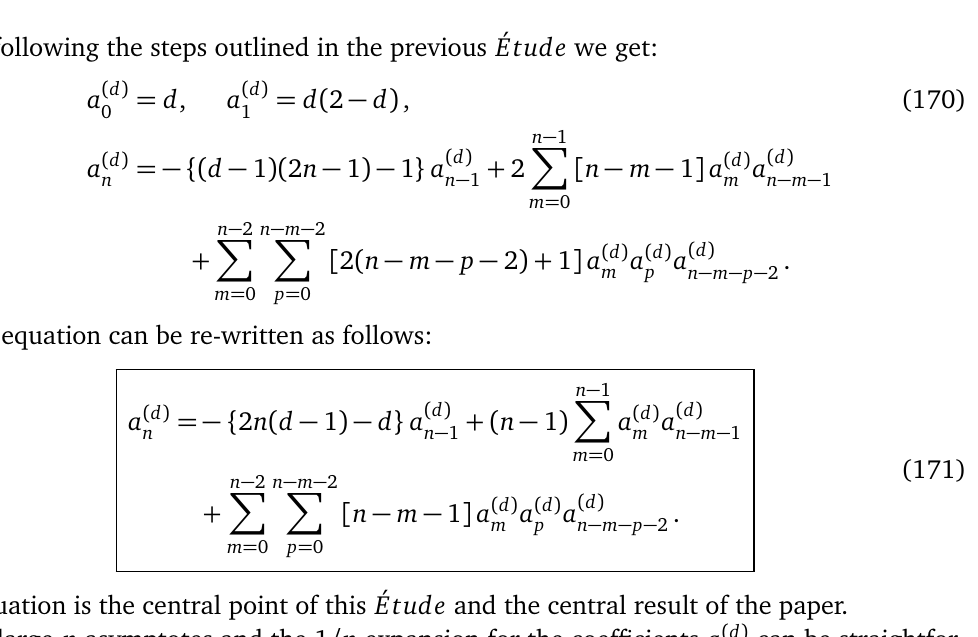
( d ) = d ( 2 − d ) < 0. Let us 1 τ z = − 11 22